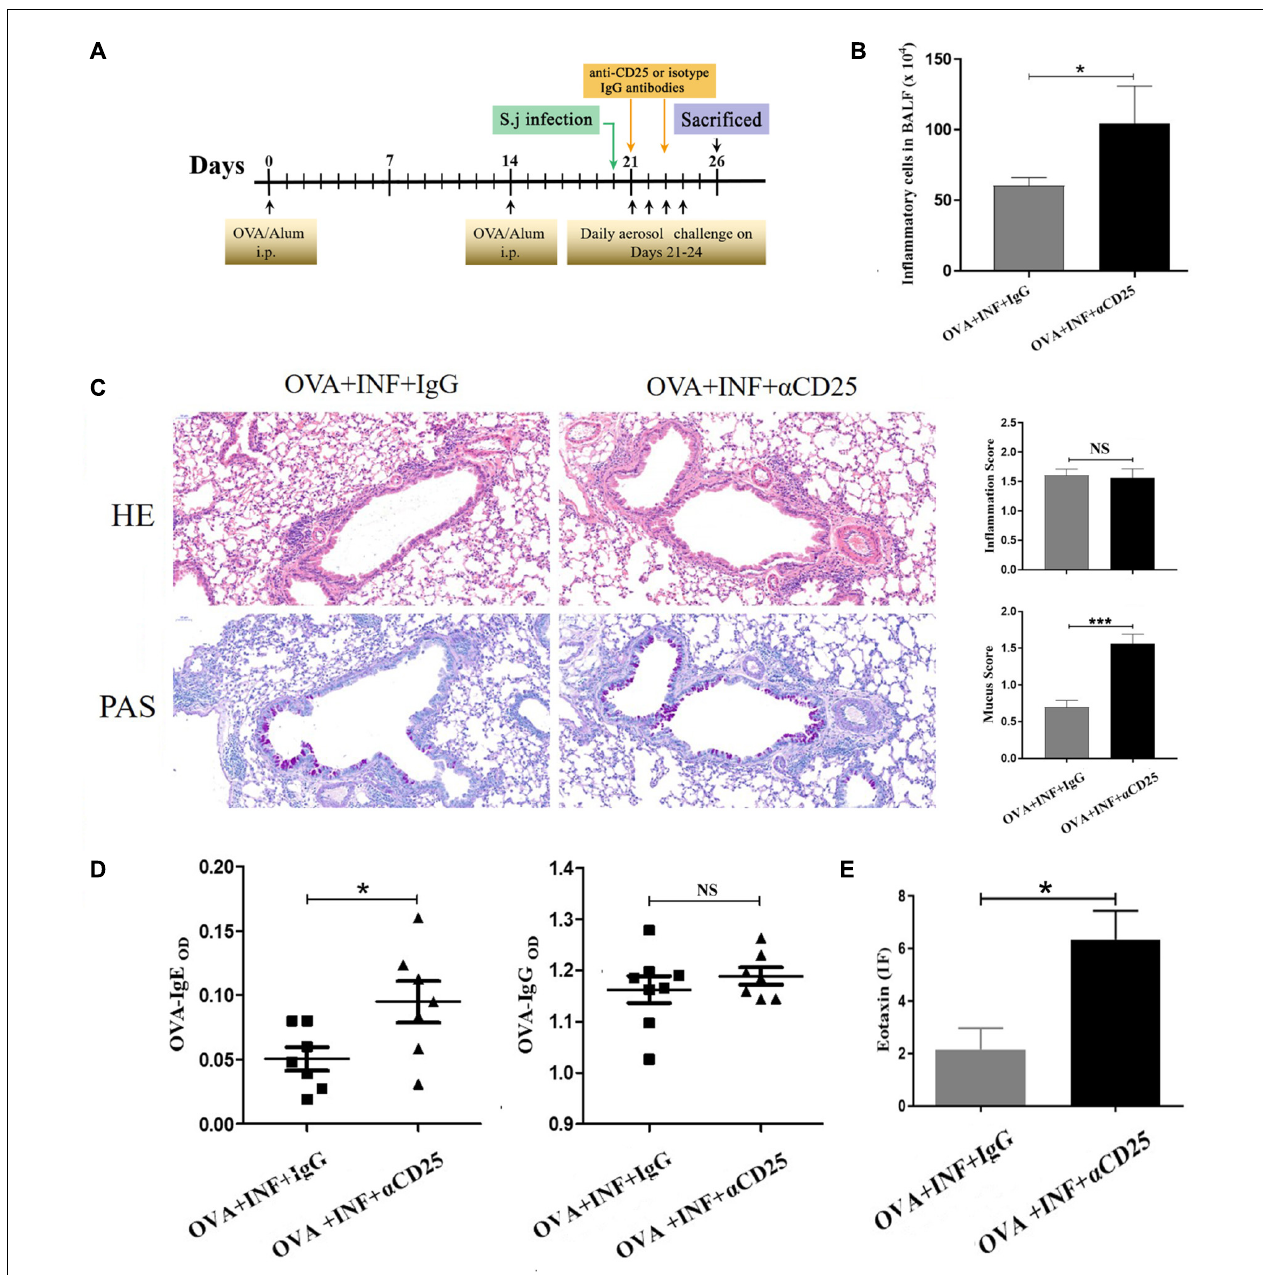
FIGURE 7 | In vivo depletion of Treg cells counteracted the protective effect of lung-stage S. japonicum infection on OVA-induced AAI. (A) Design of experiment for testing the role of Treg cells in the protective effect mediated by lung-stage S. japonicum infection. (B) Comparisons of total inflammatory cell counts in BALF between lung-stage schistosome-infected mice treated with either anti-CD25 antibody or isotype control IgG ( n = 8 mice per group, experiment performed twice). (C) Lung histopathology analysis of lung-stage schistosome–infected mice treated with either anti-CD25 antibody or isotype control IgG. Upper, H&E staining; lower, PAS staining ( n = 8 mice per group, experiment performed twice). (D) Comparisons of OVA-specific IgE and IgG in sera between Treg cell–depleted and control mice ( n = 8 mice per group, experiment performed twice). (E) Comparisons of eotaxin levels in BALF between lung stage–infected mice treated with either anti-CD25 antibody or isotype control ( n = 8 mice per group, experiment performed twice). Data are shown as mean ± SEM. * P < 0.05, *** P < 0.001 by one-way analysis of variance (ANOVA) with Tukey